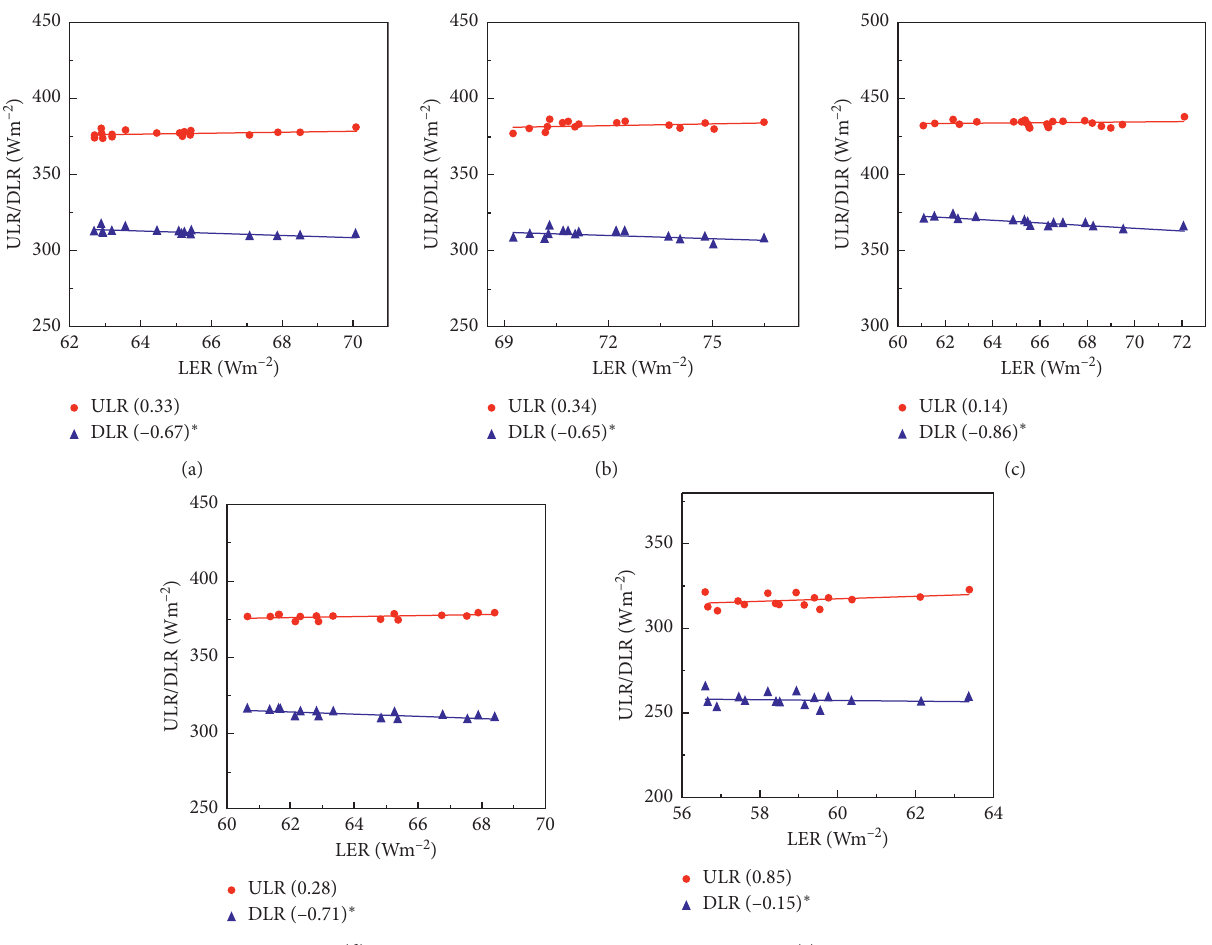
Figure 6: Slopes of (a) annual and (b–e) seasonal linear regressions for relationship between LER and ULR (red) and DLR (blue) (unit: Wm − 2 ) under all-sky conditions in China during the period 2001–2016 (asterisk indicates 95% significance